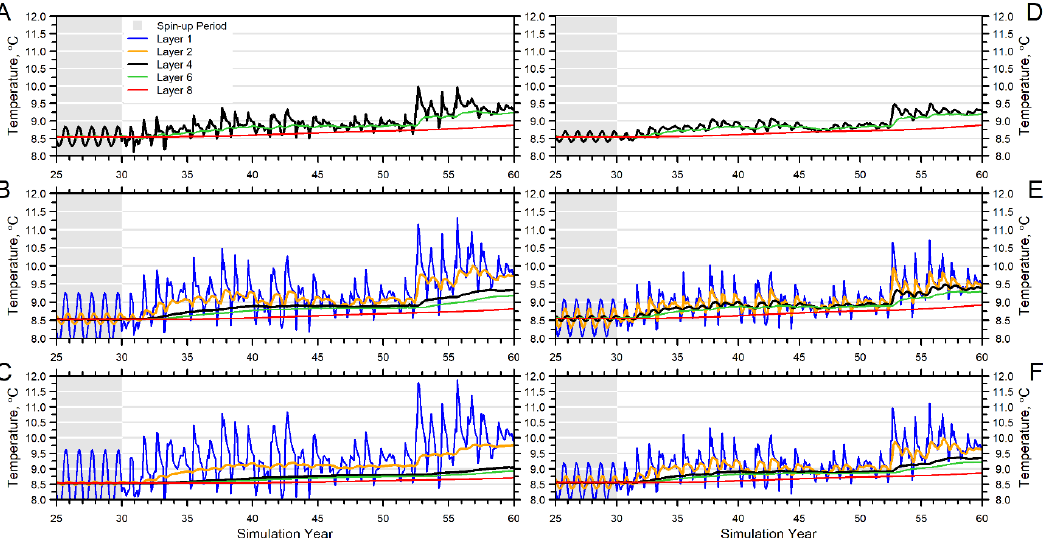
Figure 5. Simulated temperature hydrographs by model layer at the ( A – C ) UPLAND well and ( D